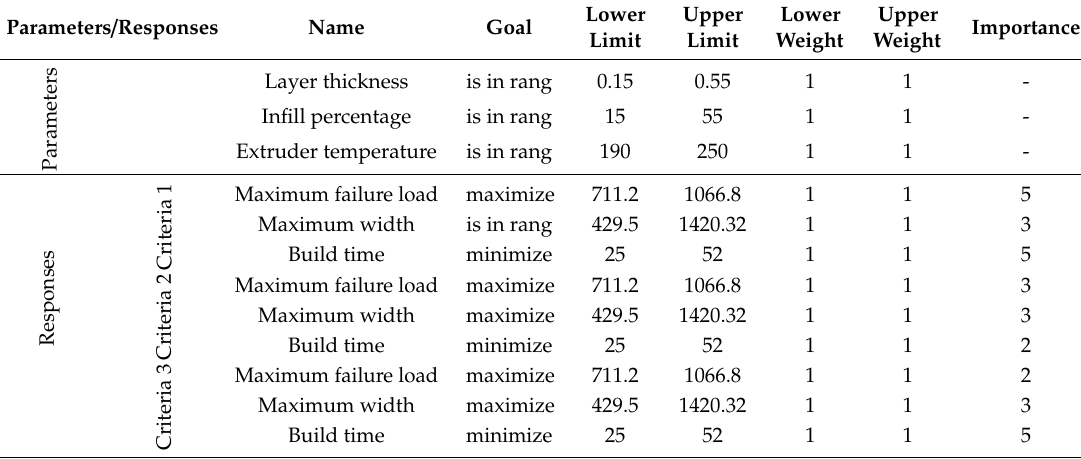
Table 7. Constraints and criteria of input parameters and